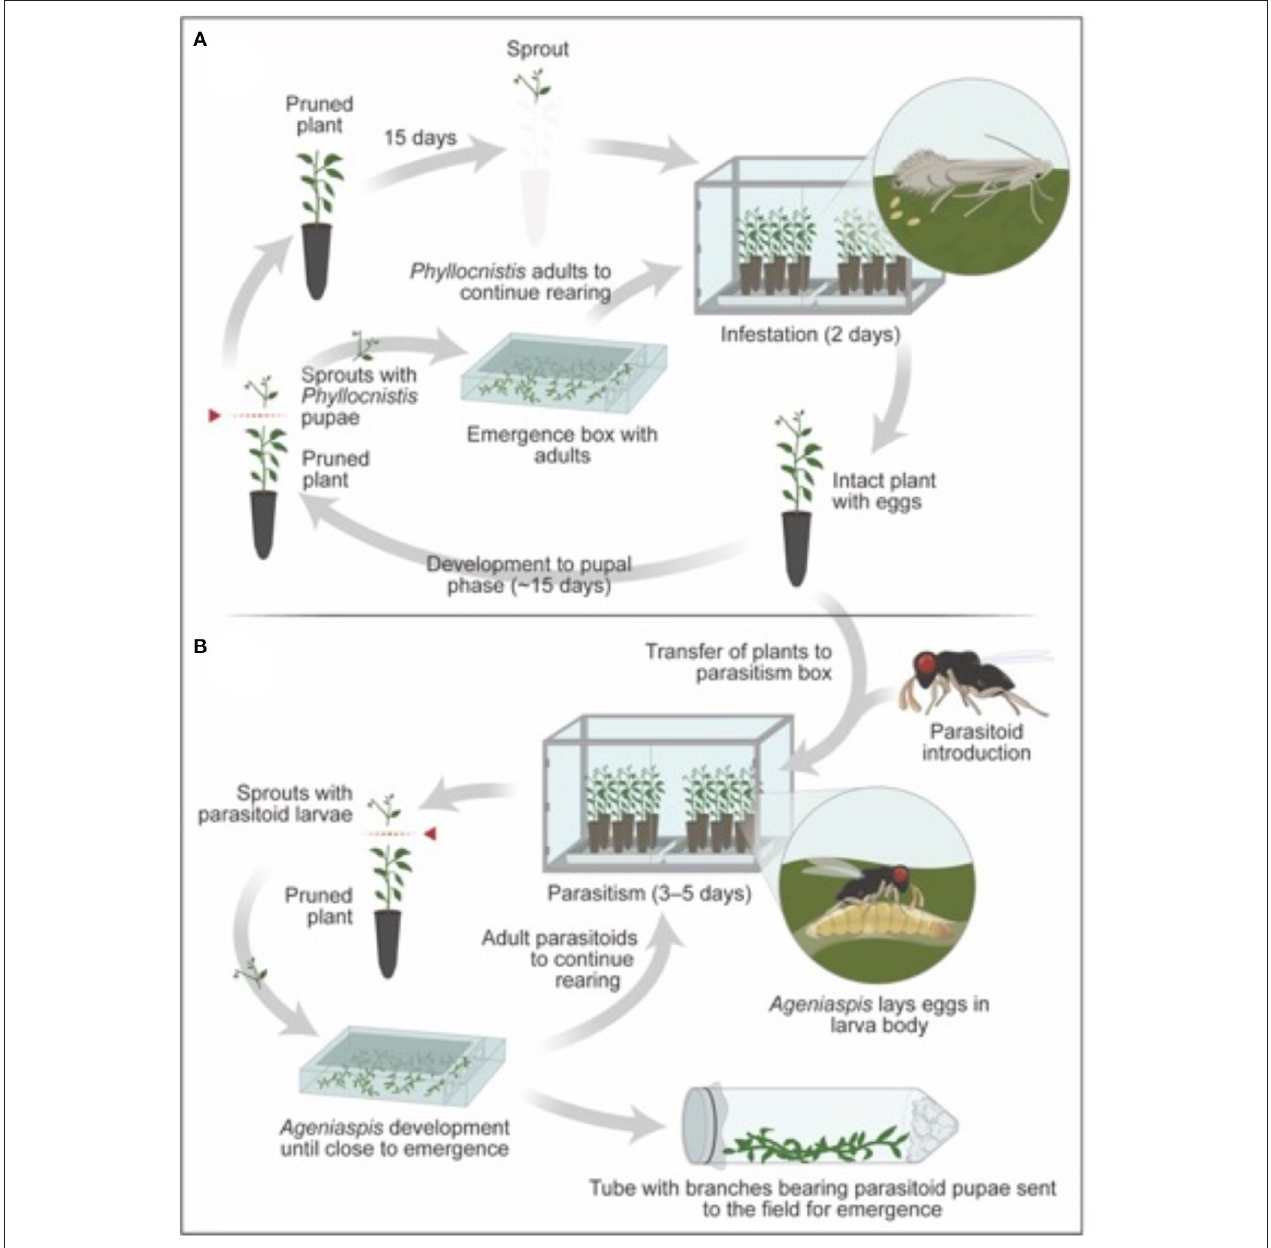
FIGURE 1 | Scheme of the production process of Phyllocnistis citrella (A) for the rearing of its parasitoid Ageniaspis citricola (B) for inoculative releases in a biological-control program (Parra, 2021). time the parasitoid had spread throughout the state (Parra, 2021) ( Figure 2